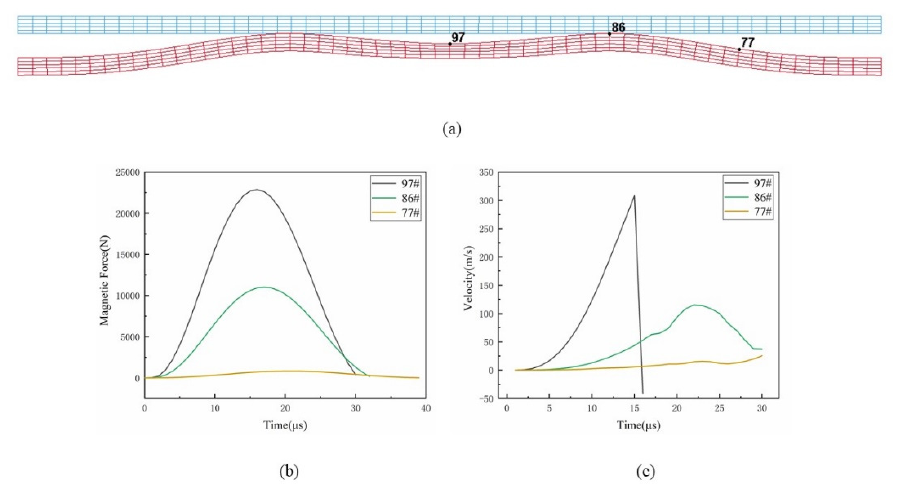
Figure 16. The electromagnetic force and velocity curves of the nodes. ( a ) The position of the node; ( b ) electromagnetic force; ( c ) typical node velocity variation.